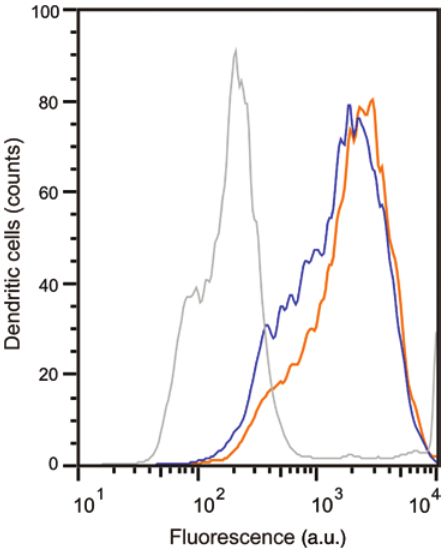
Figure 2: Surface display of peptide loaded MHC class II by both immature and mature human monocyte-derived DCs. Histogram with FACS data of MHC class II surface staining of DCs differentiated from peripheral blood mononuclear cells (with PE labeled antibody L243). Blue curve: inactivated DCs (immature). Orange curve: DCs stimulated overnight with 1 μ g ml -1 of the TLR4 ligand LPS (mature DCs). Gray curve: isotype control (PE labeled mouse IgG2a). L243 does not bind to MHC class II with the invariant Li chain associated